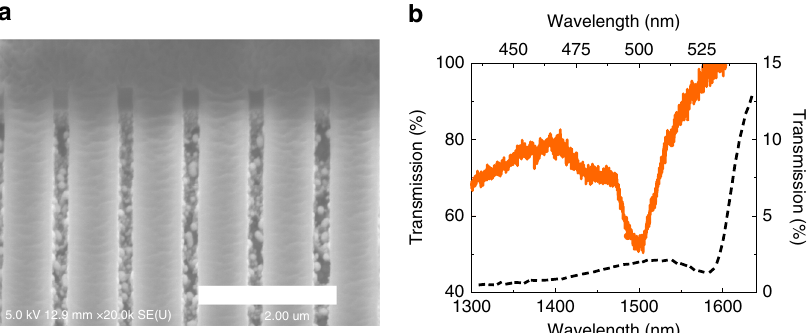
Fig. 3 The linear properties of MAPbBr 3 perovskite metasurfaces. a The tilt-view SEM image of the perovskite metasurface, scale bar is 2 μ m. b The experimentally measured transmission spectra at near-infrared (solid line) and visible regions (dashed line)